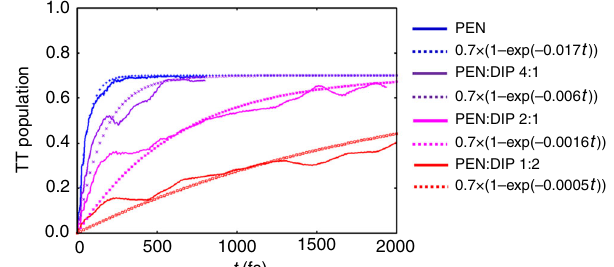
Fig. 5 Calculated evolution of triplet pair population. Population of triplet pair (TT) from quantum dynamics calculations (solid lines) and exponential fi ts (dotted lines). At t = 0, a singlet exciton is localized on the center molecule of the herringbone trimer model